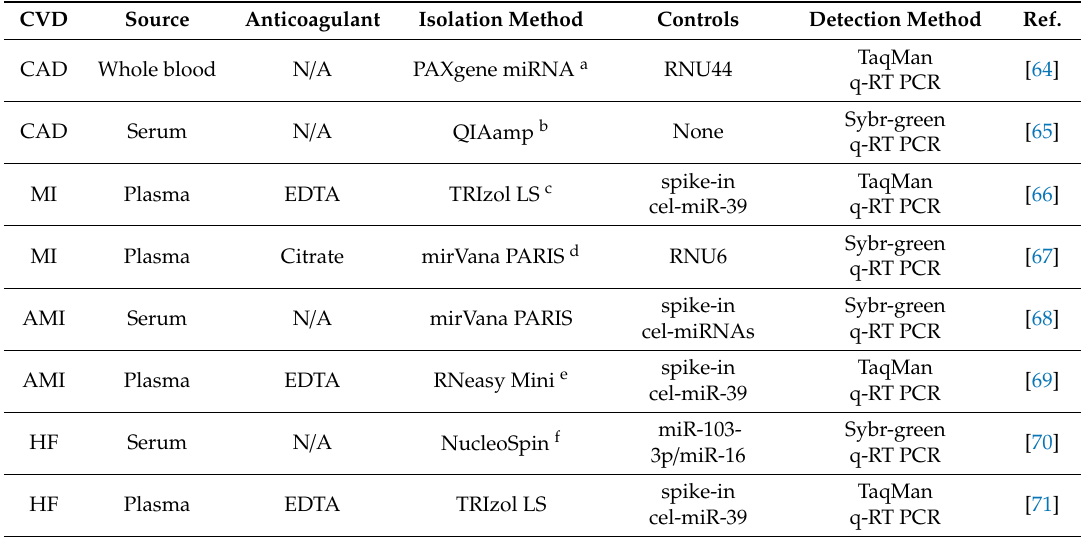
Table 1. Examples of di ff erent strategies for the determination of circulating miRNAs